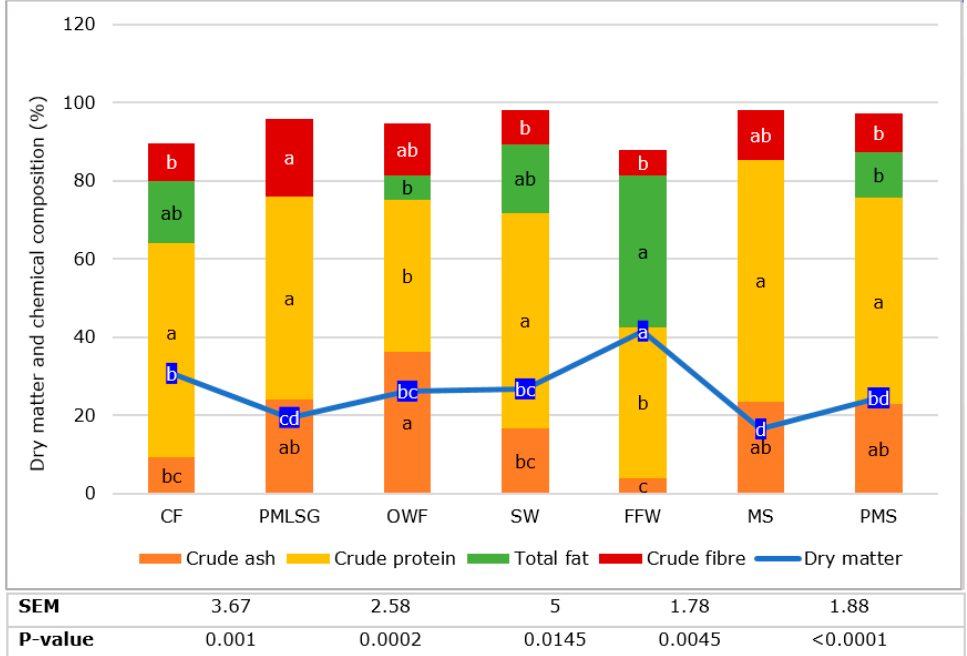
Figure 2. The mean values of the dry matter and the chemical composition of the larvae reared on different substrates 1 (macronutrients expressed in % of dry matter). For each nutrient, means with different superscript letters differ significantly (two-way ANOVA followed by Tukey’s post hoc test analysis p < 0.05). Chicken feed (CF; control diet), pig manure slurry mixed with roadside silage grass (PMLSG), organic wet fraction (OWF), slaughter waste (SW), fast food waste (FFW), mushroom stems (MS) and pig manure solid (PMS).